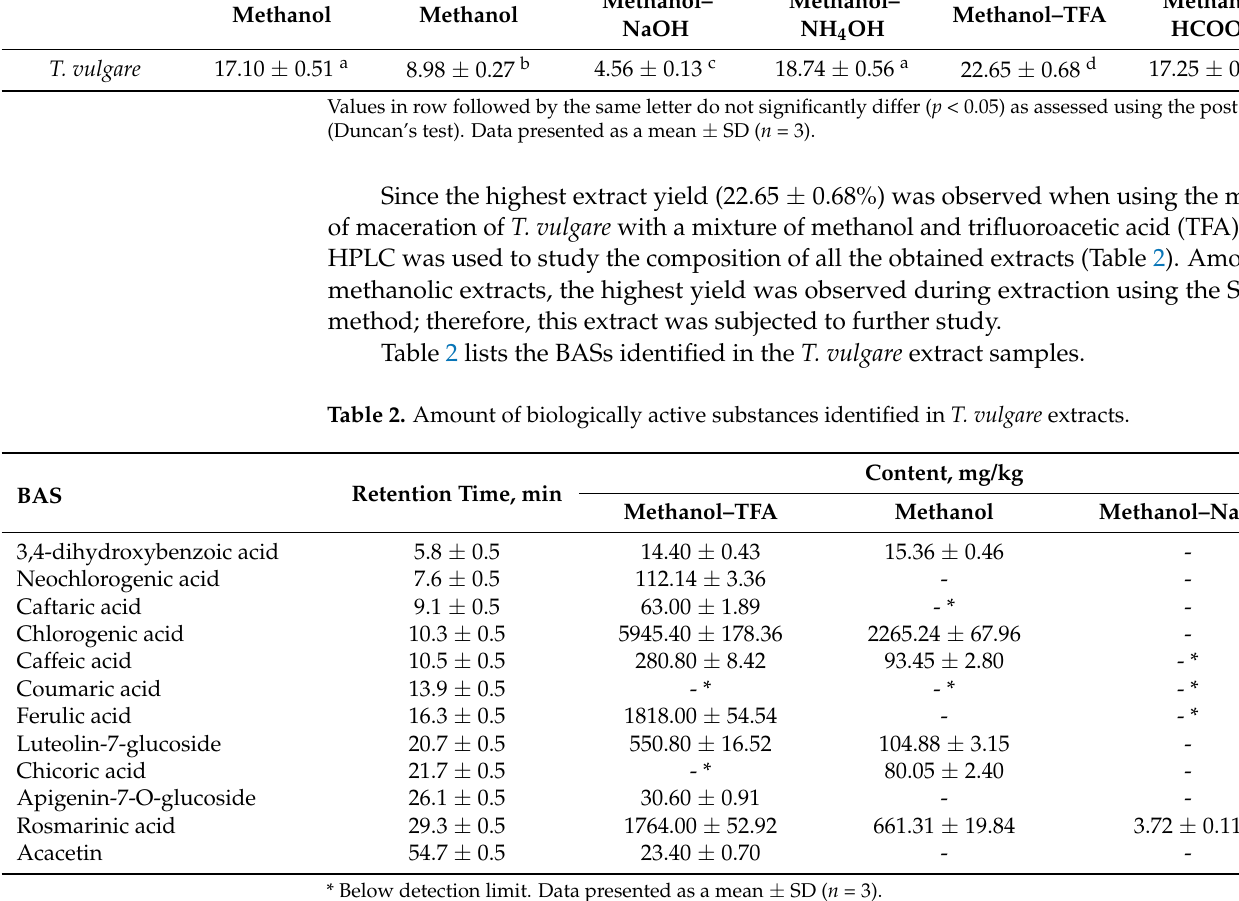
Extract Yield, wt. %